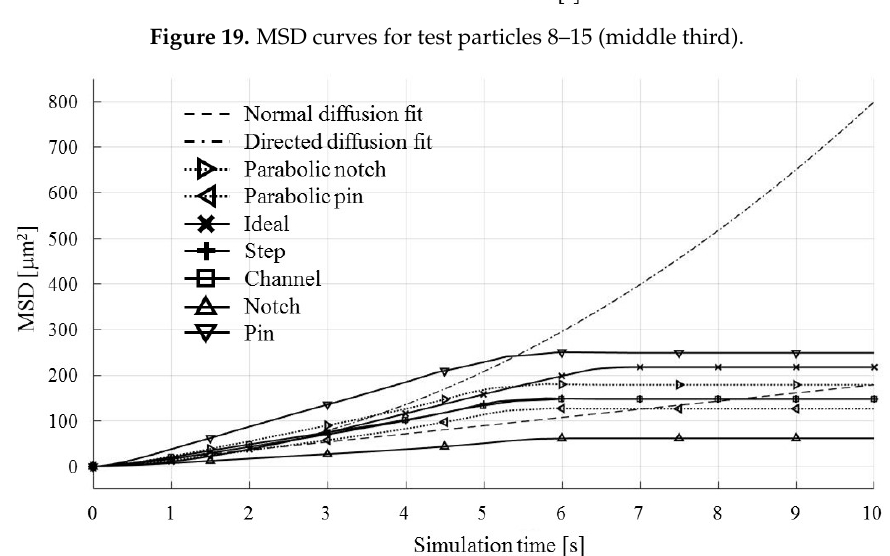
Figure 19. MSD curves for test particles 8–15 (middle third).